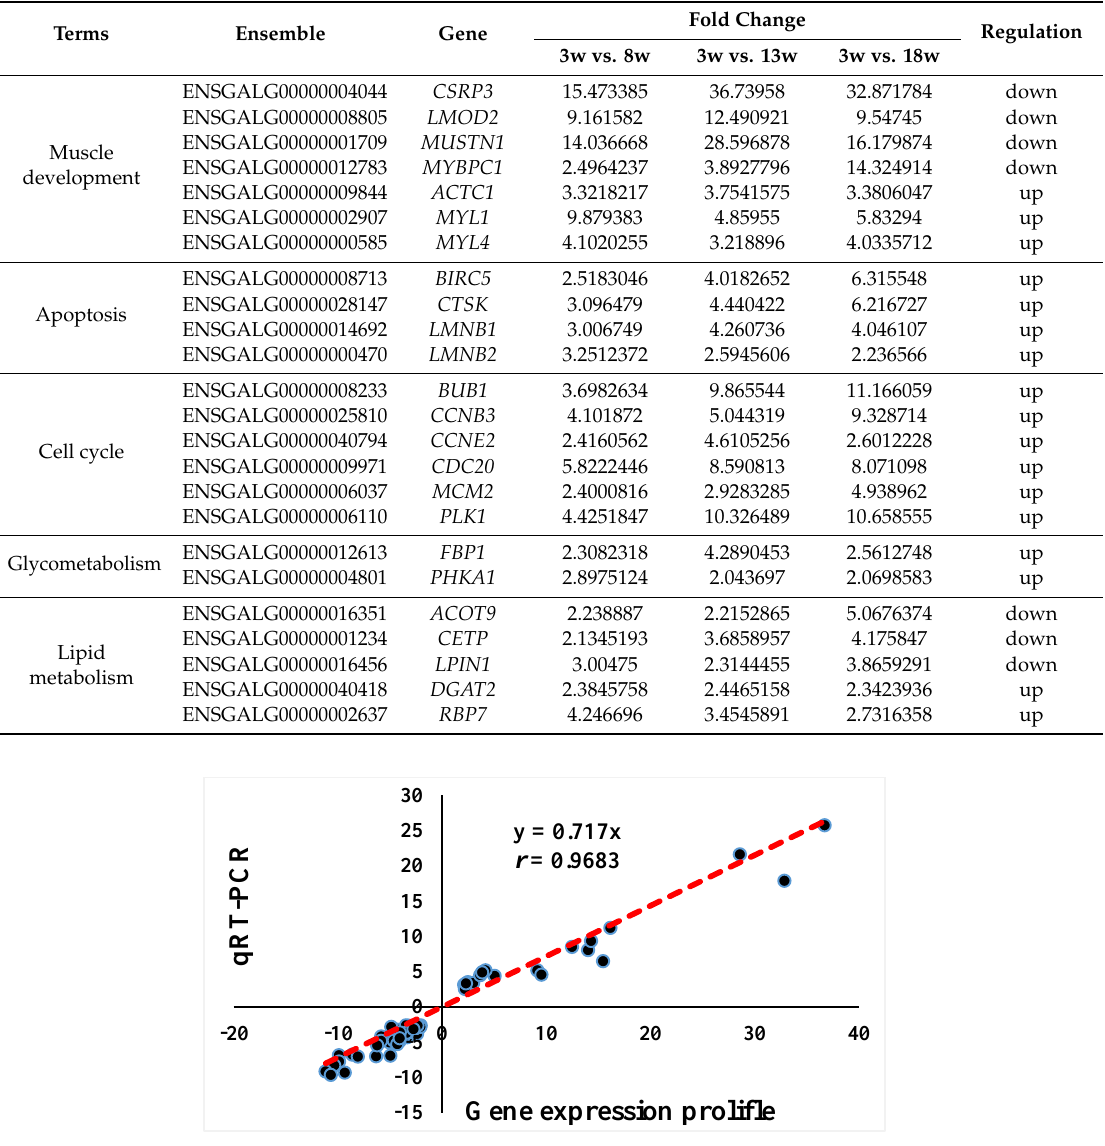
Figure 3. Spearman rank correlation analysis of gene expression profiling and qRT-PCR results of 24 genes in three comparisons. A high correlation coefficient ( r = 0.9683, p < 0.01) was present, indicating that the gene expression profiling data were reliable. n = 72. Table 4. The screened 24 DEGs related to muscle development, cell number, and energy metabolism from data of gene expression profiling.